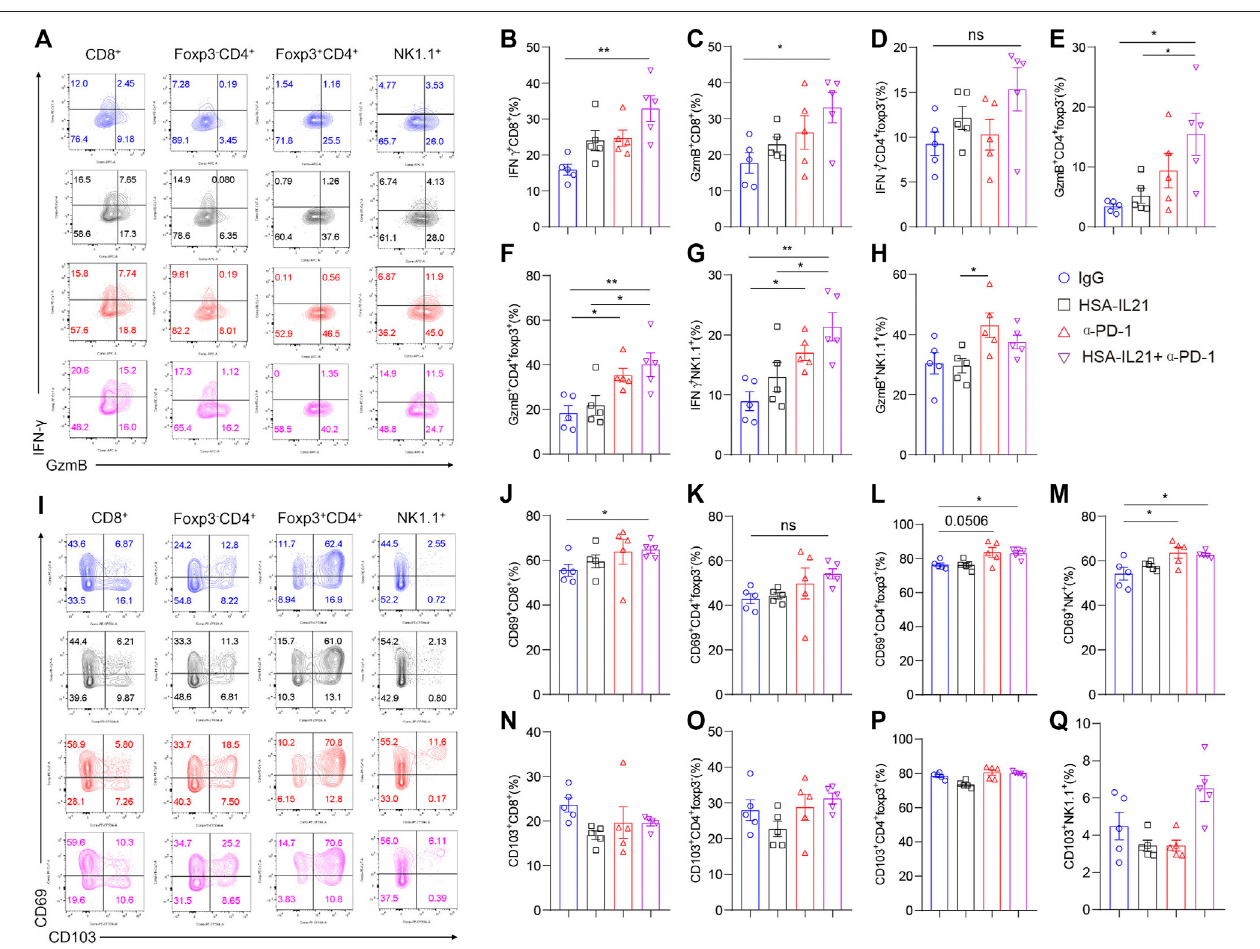
FIGURE 3 | Combination therapy enhances the effector function of tumor-in fi ltrating lymphocytes. (A – Q) MC38 tumor cells (1 × 10 6 ) were injected intradermally to B6 mice, 9 days after tumor inoculation, MC38 tumor-bearing mice were treated with IgG, HSA-IL21, α -PD-1, HSA-IL21/ α -PD-1, 96 h later, tumors were resected and analyzed by fl ow cytometry. (A and I) Representative fl ow plots showing IFN- γ , GzmB, CD69 and CD103 staining in CD8 + , Foxp3 - CD4 + , Foxp3 + CD4 + and NK cells. (B – H) QuantitativepercentageofIFN- γ and GzmB expression inCD8 + ,Foxp3 - CD4 + ,Foxp3 + CD4 + Tand NKcells. Datawerepresentedasmean ± SEM, n (cid:2) 5, *p < 0.05, ** p < 0.01, *** p < 0.001, **** p < 0.0001, one-way ANOVA test was performed. (J – Q) Quantitative percentage of CD69 expression in CD8 + , Foxp3 - CD4 + , Foxp3 + CD4 + T and NK cells. Data were presented as mean ± SEM, n (cid:2) 5, *p < 0.05, ** p < 0.01, *** p < 0.001, **** p < 0.0001, one-way ANOVA was